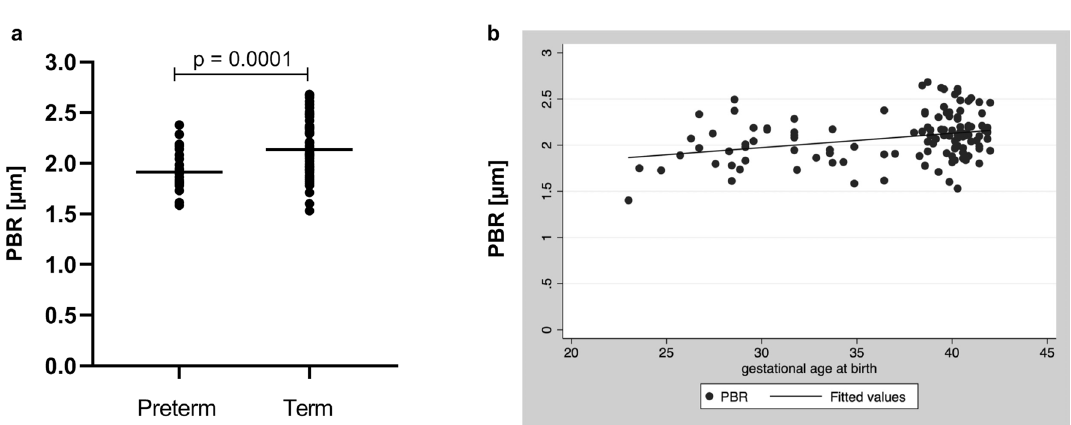
Figure 3. ( a ) PBR values obtained at 36–72 h of life in preterm (n = 24) and term (n = 85) neonates. ( b ) Linear regression showing association of PBR at first measurement and gestational age at birth (p < 0.001 adjusted for postnatal